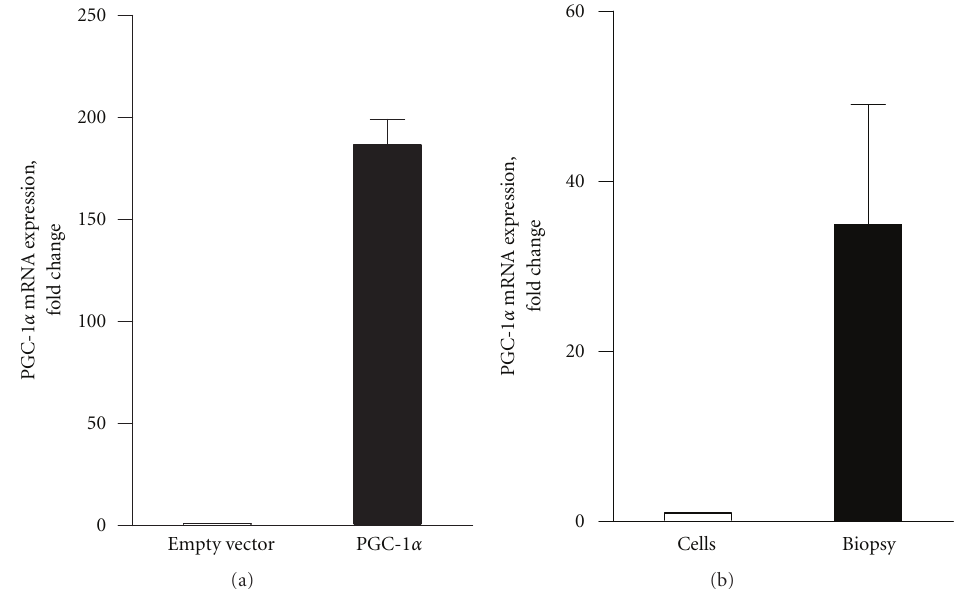
Figure 2: mRNA level of PGC-1 α in human skeletal muscle cells infected with retrovirus coding for PGC-1 α compared to control cells infected with empty virus (a), and in muscle biopsies compared to cell cultures (b). mRNA was isolated from muscle biopsies and cultured myotubes, and mRNA expression was assessed by RT-PCR, as described in Section 2. Values are presented as means ± SEM of 3 experiments, each representing one donor, with 3 replicates each, normalized to levels of housekeeping gene